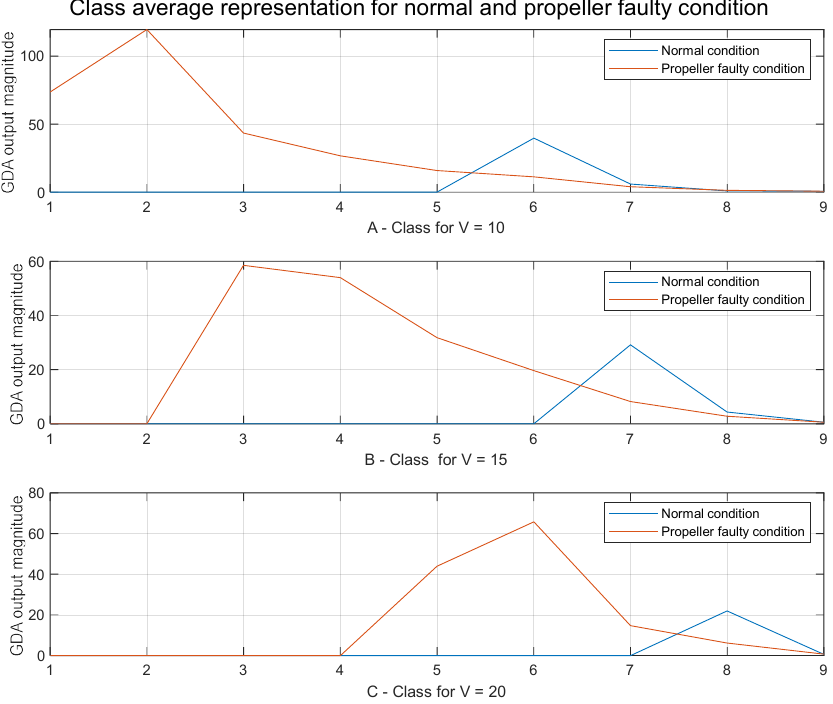
Figure 12. Classes average representation for V = 10 (A), V = 15 (B) and V = 20 (C).